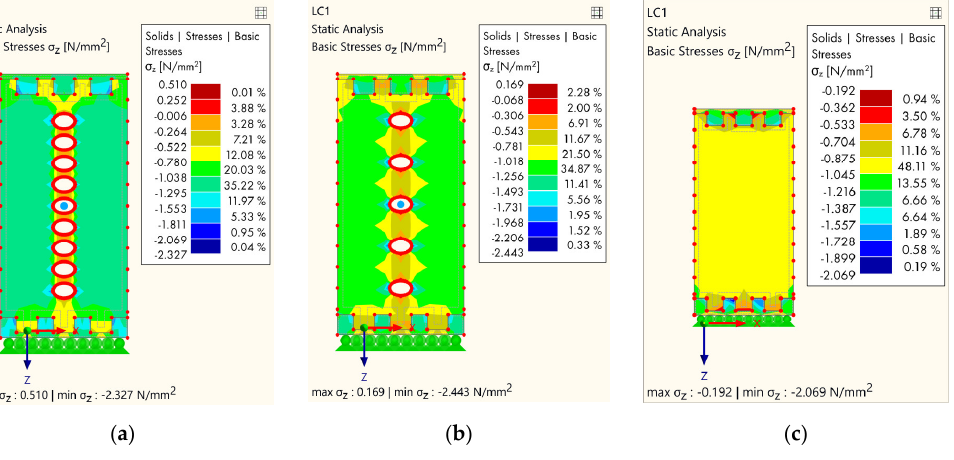
Figure 15. Results of FEM analysis—stress: ( a ) The central part with cavities; ( b ) the central part and each subsequent lamella with cavities; ( c ) normal—without cavities.